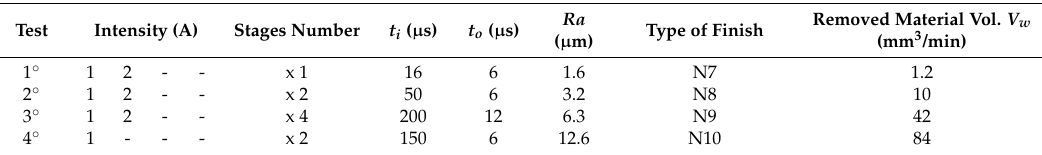
Table 6. Finishing parameters for MoCuSi ingot.